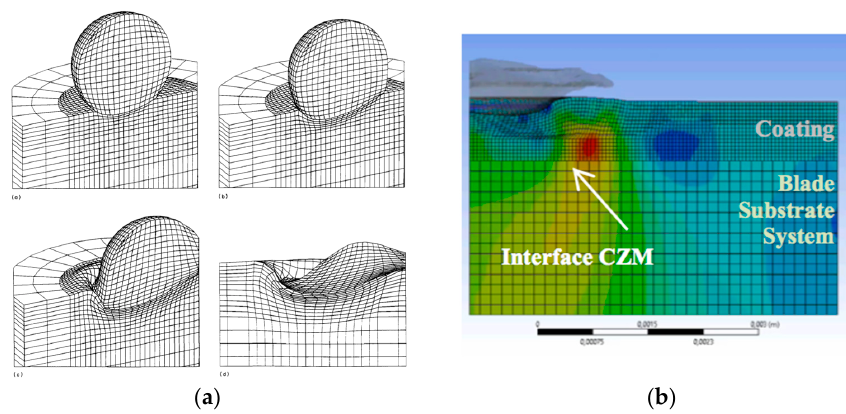
Figure 12. ( a ) 3D FEM modelling of a water droplet impact in a thick polymer solid, from [22]; ( b ) numerical modelling of normal stress due to rain droplet impact. Interface CZM defines the failure resistance between contact layers, as in [29].